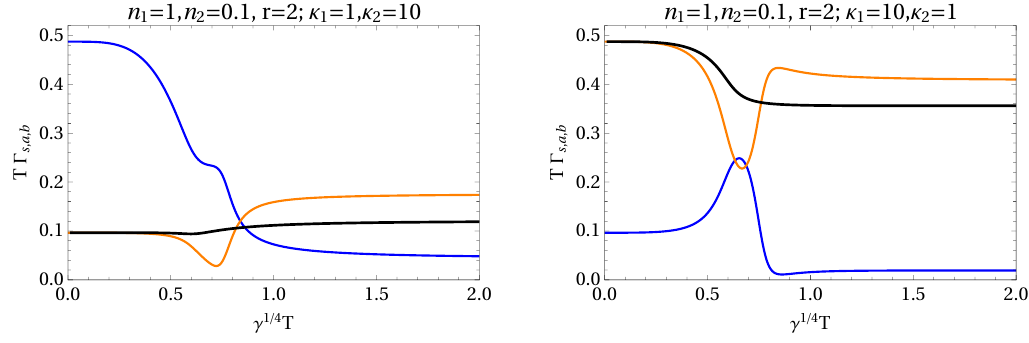
Figure 11 . Attenuation coe(cid:14)cients (cid:0) a;b of the sound eigenmodes (slower mode a in blue, faster mode b in orange) for unequal conformal systems with di(cid:11)erent (cid:20) . The black line gives the Kubo formula result for sound